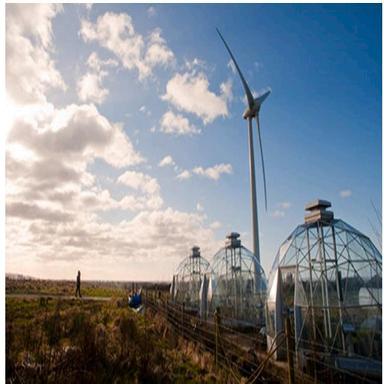
Hazelrigg weather station and campus WT.